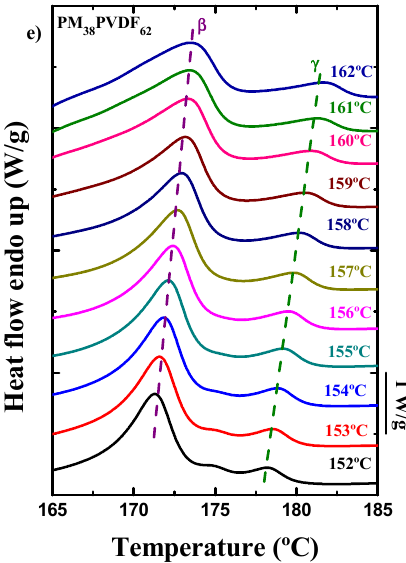
Figure 12. DSC PVDF melting curves after the isothermal crystallization at different temperatures of ( a ) PVDF homopolymer, ( b ) PM 23 - b -PVDF 77 , ( c ) PM 38 - b -PVDF 62 , ( d ) PM 23 PVDF 77 , and ( e ) PM 38 PVDF 62 samples.